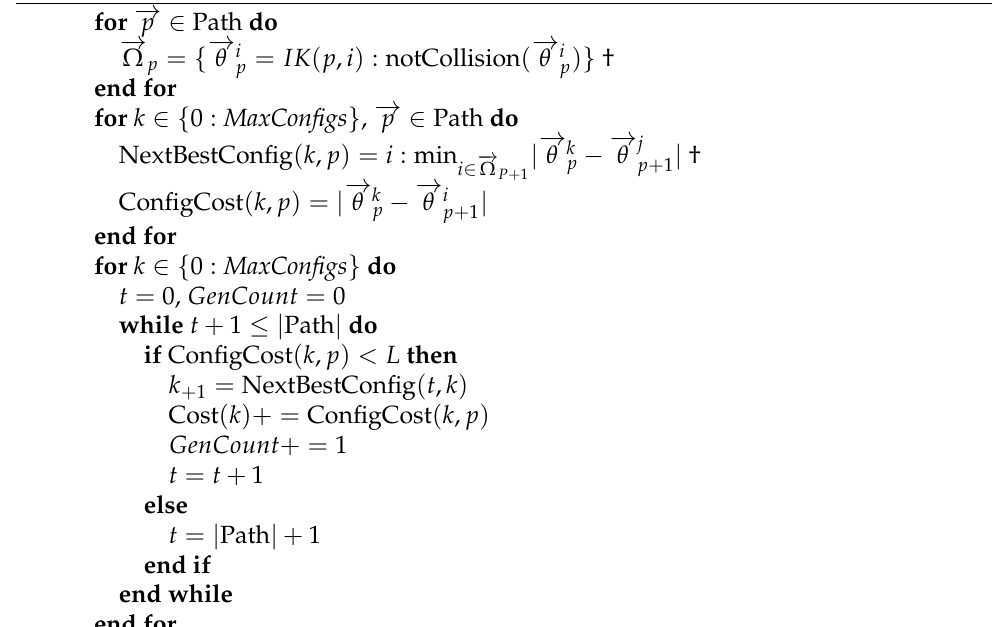
Algorithm 1: Calculate possible collision-free paths, and the cost of each path from each potential initial